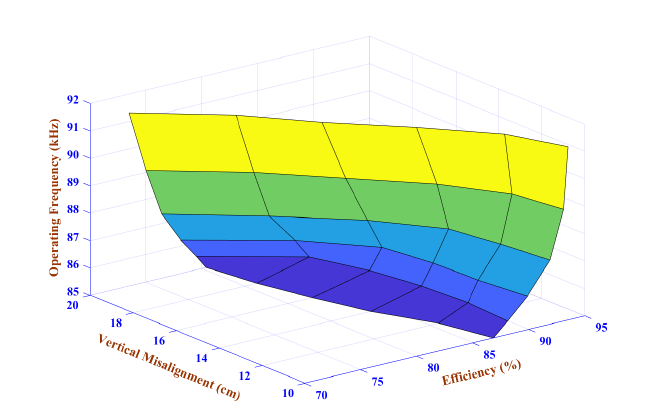
Figure 18. Power transfer efficiency against to the vertical misalignment and operating frequency.